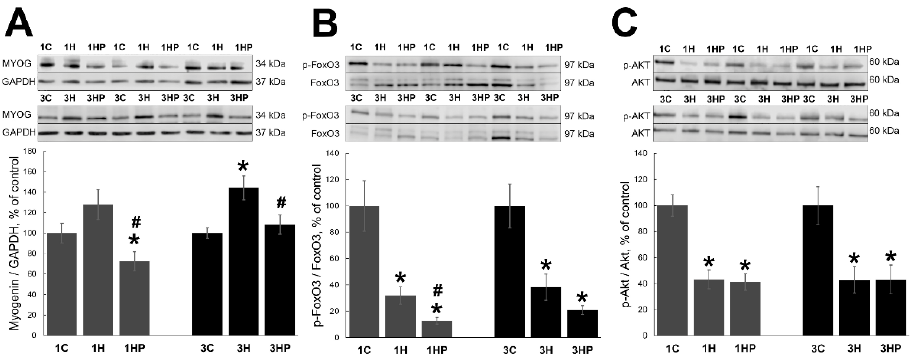
Figure 3. Evaluation of the MYOG ( A ), p-FoxO3 ( B ) and p-AKT ( C ) content in soleus muscles of non-treated control rats (1C and 3C), rats after 1 and 3 days of unloading (1HS and 3HS), and 1 and 3 days of HS with PRB inhibitor (1HP and 3HP). Values are normalized to the level of GAPDH ( A ), total FoxO3 ( B ) and total Akt ( C ) in each sample. n = 8. * indicates a significant difference from the control, # indicates a significant difference from the HS group, p < 0.05.